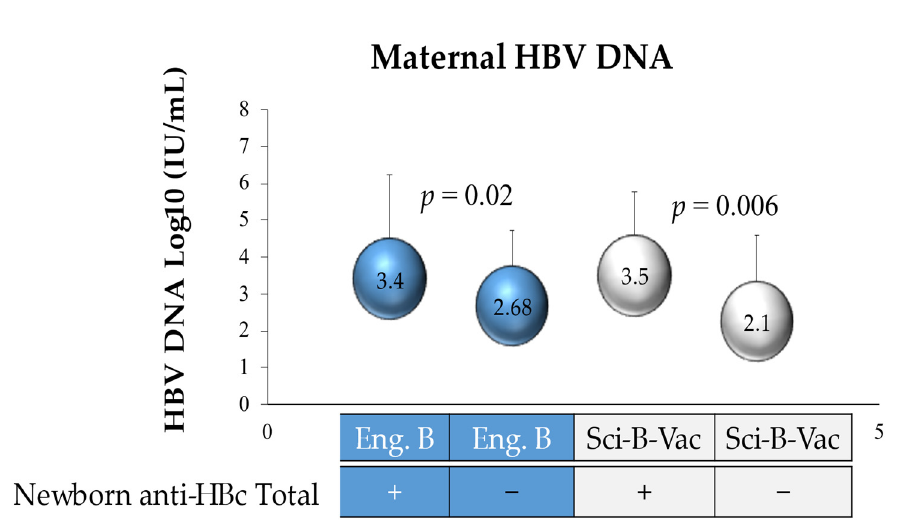
Figure 4. HBV DNA log 10 of mothers of anti-HBc-positive newborns. Eng. B, Engerix-B.